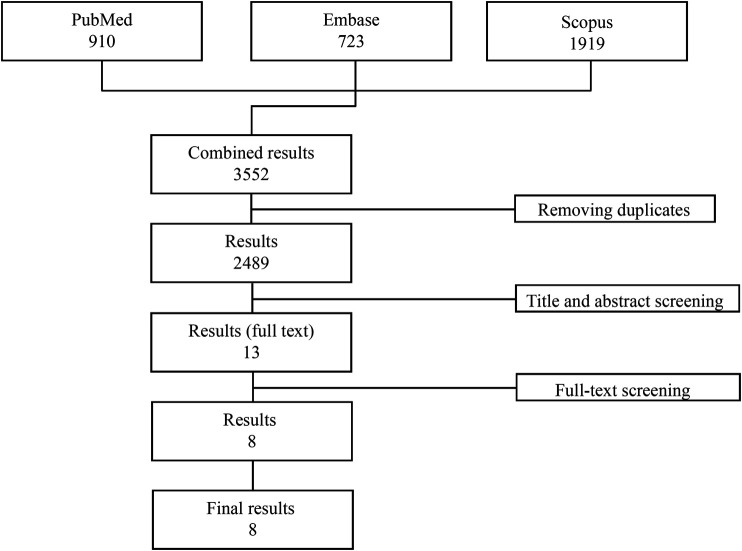
Study flow-chart.